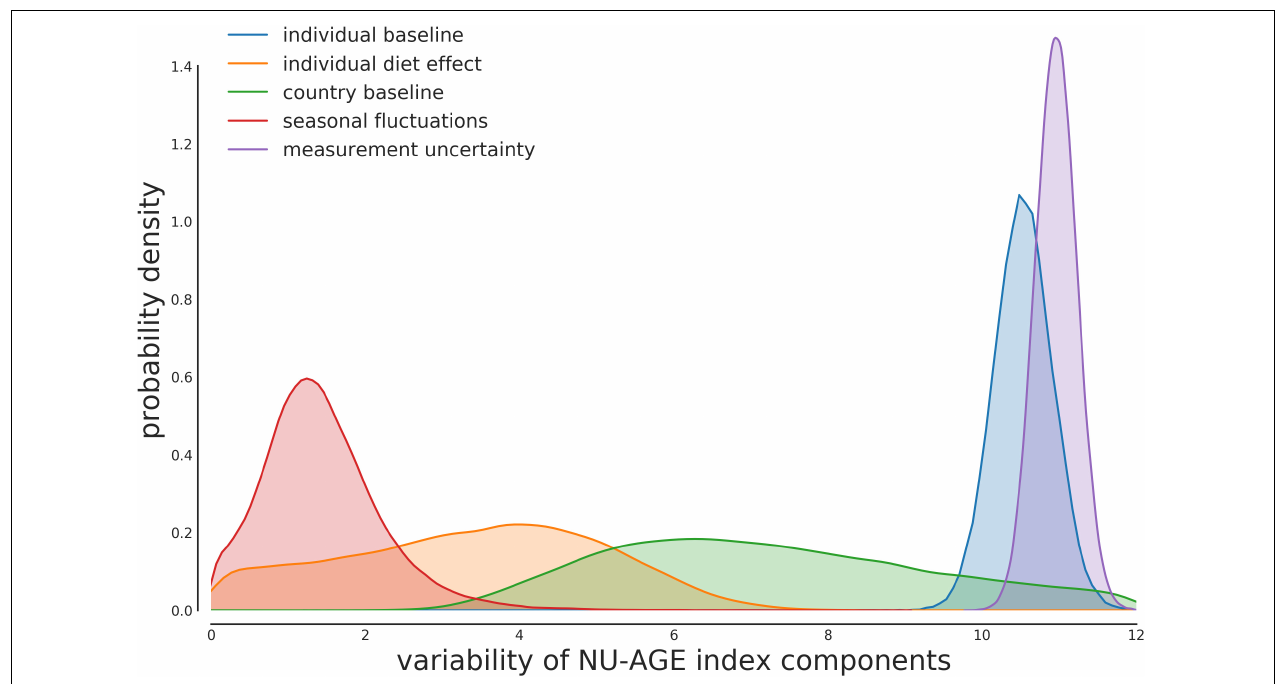
FIGURE 2 | Posterior distribution for the variability components of each part of the model. The majority of the variability is composed of the individual variability in the baseline value and the measurement uncertainty. The measurement uncertainty is slightly higher than the between-individual variability, as expected from the model described in Figure 1